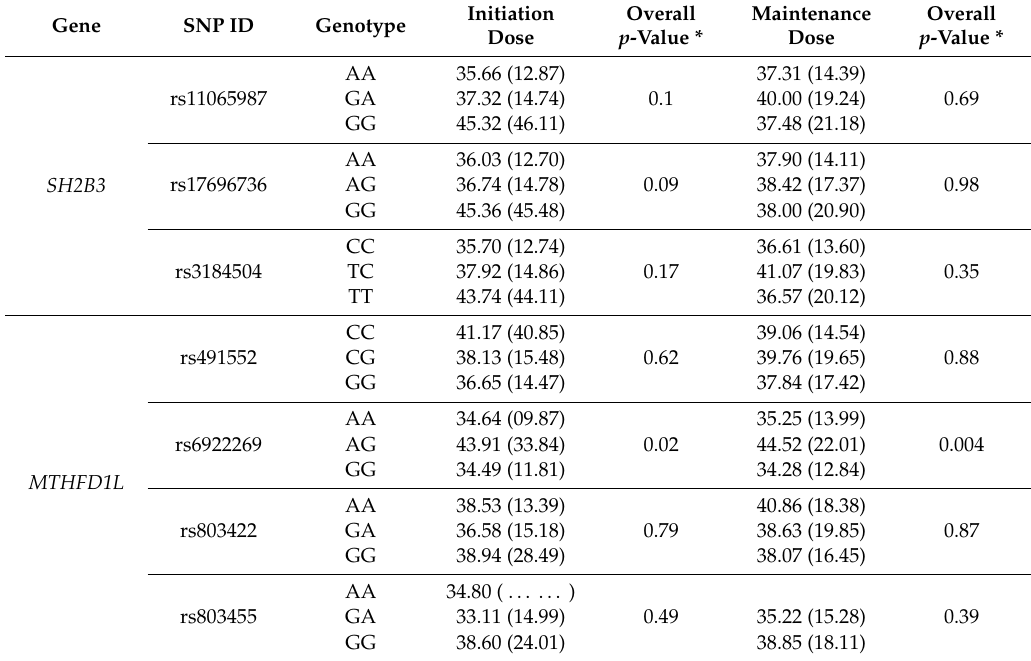
Table 4. Association of SH2B3 and MTHFD1L SNPs with the variability on warfarin required